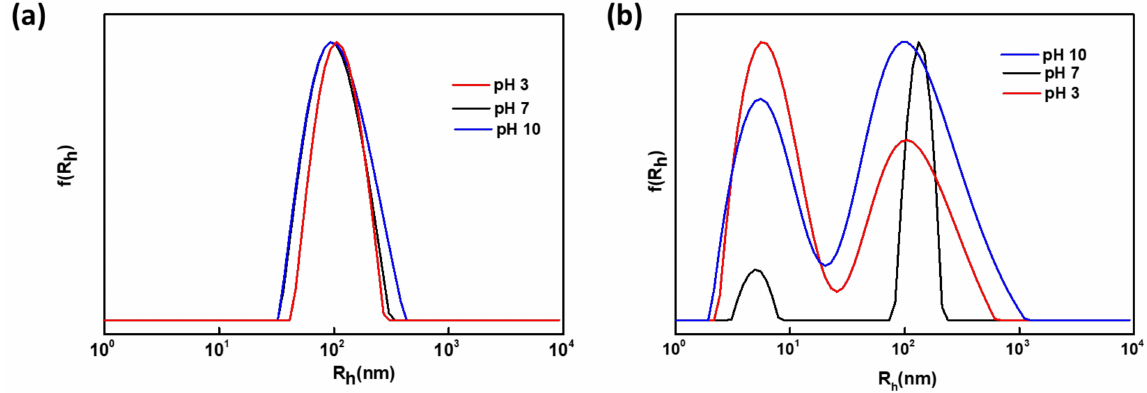
Figure 4. Size distributions from CONTIN analysis, at pH 7, 3 and 10, obtained by measurements held at 90 ◦ , for the aqueous solutions of: ( a ) P(DMAEMA 45 -co-Q 6 DMAEMA 11 )- b -POEGMA 86 and ( b ) P(DMAEMA 44 -co-Q 12 DMAEMA 12 )- b - POEGMA 86